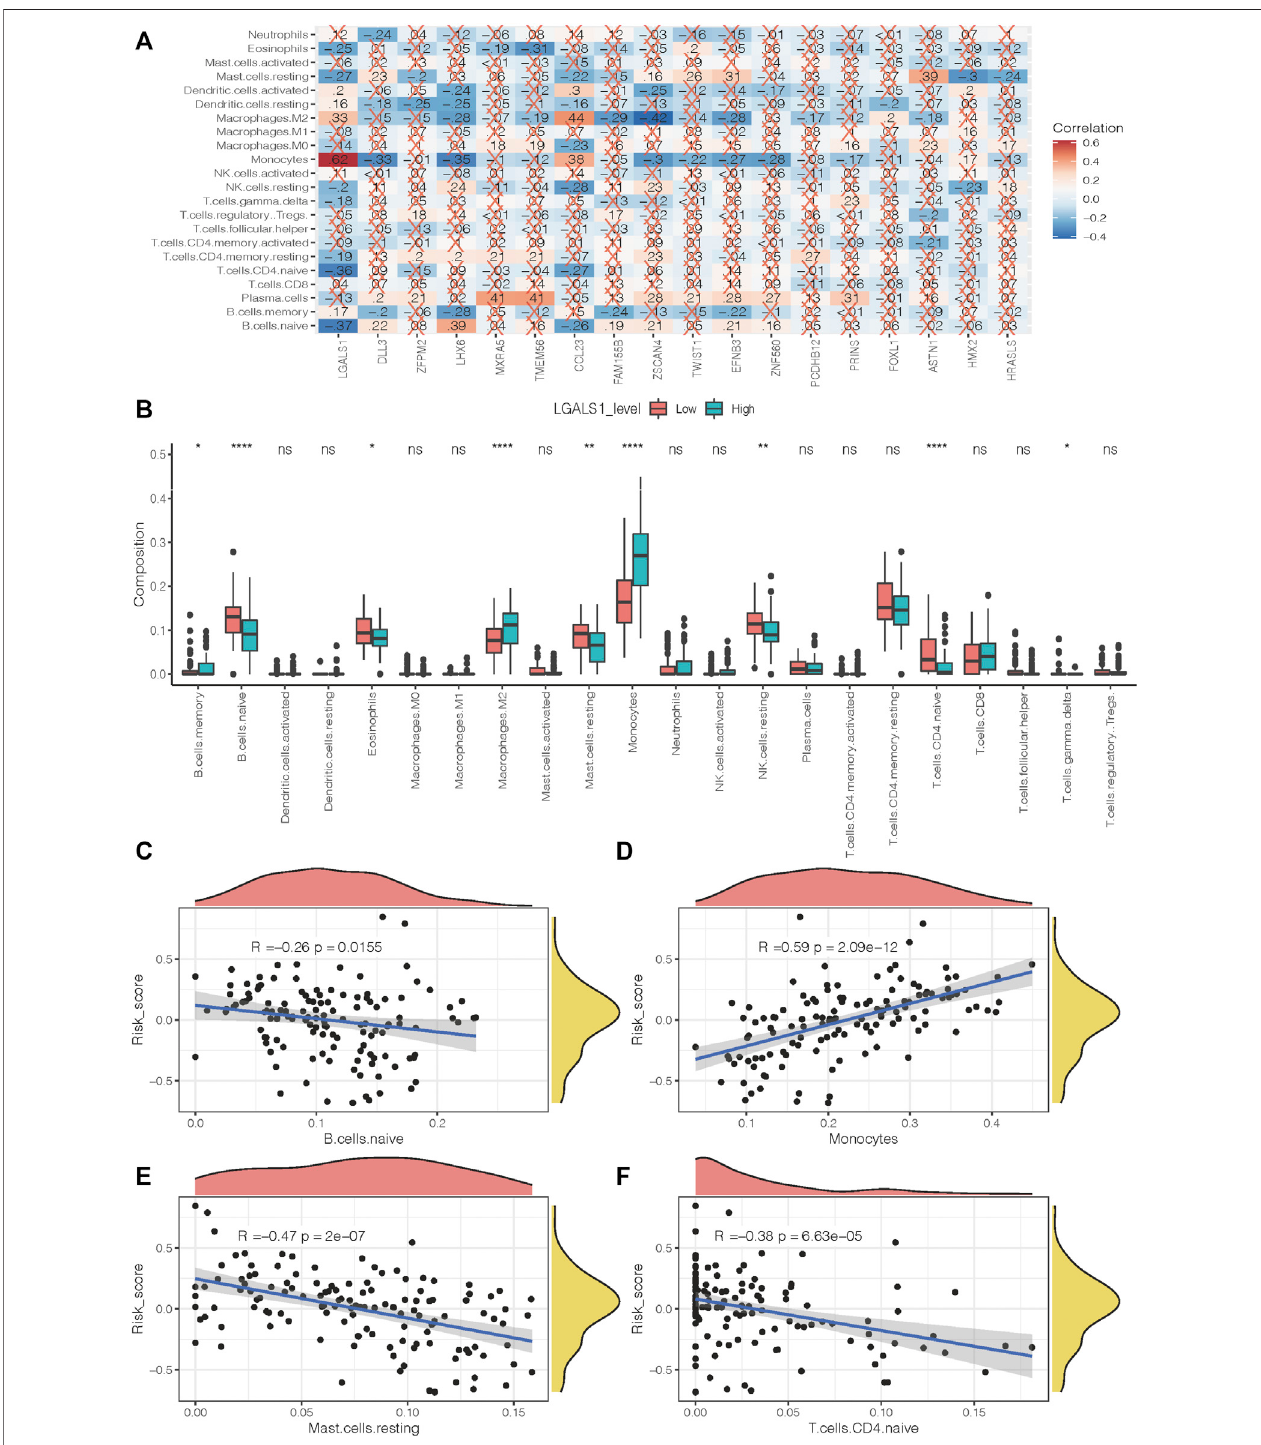
FIGURE8| Immunein fi ltrationlevelofprognosticsignature. (A) Correlationbetweenriskgenesanddifferentimmunein fi ltrationcelltypes. (B) Thecorrelationofrisk gene LGALS1 expression with immune in fi ltration level in the high- and low-risk groups. (C – F) The correlation of risk score with naïve B cells, monocytes, resting mast cells, and naïve T cells CD4.